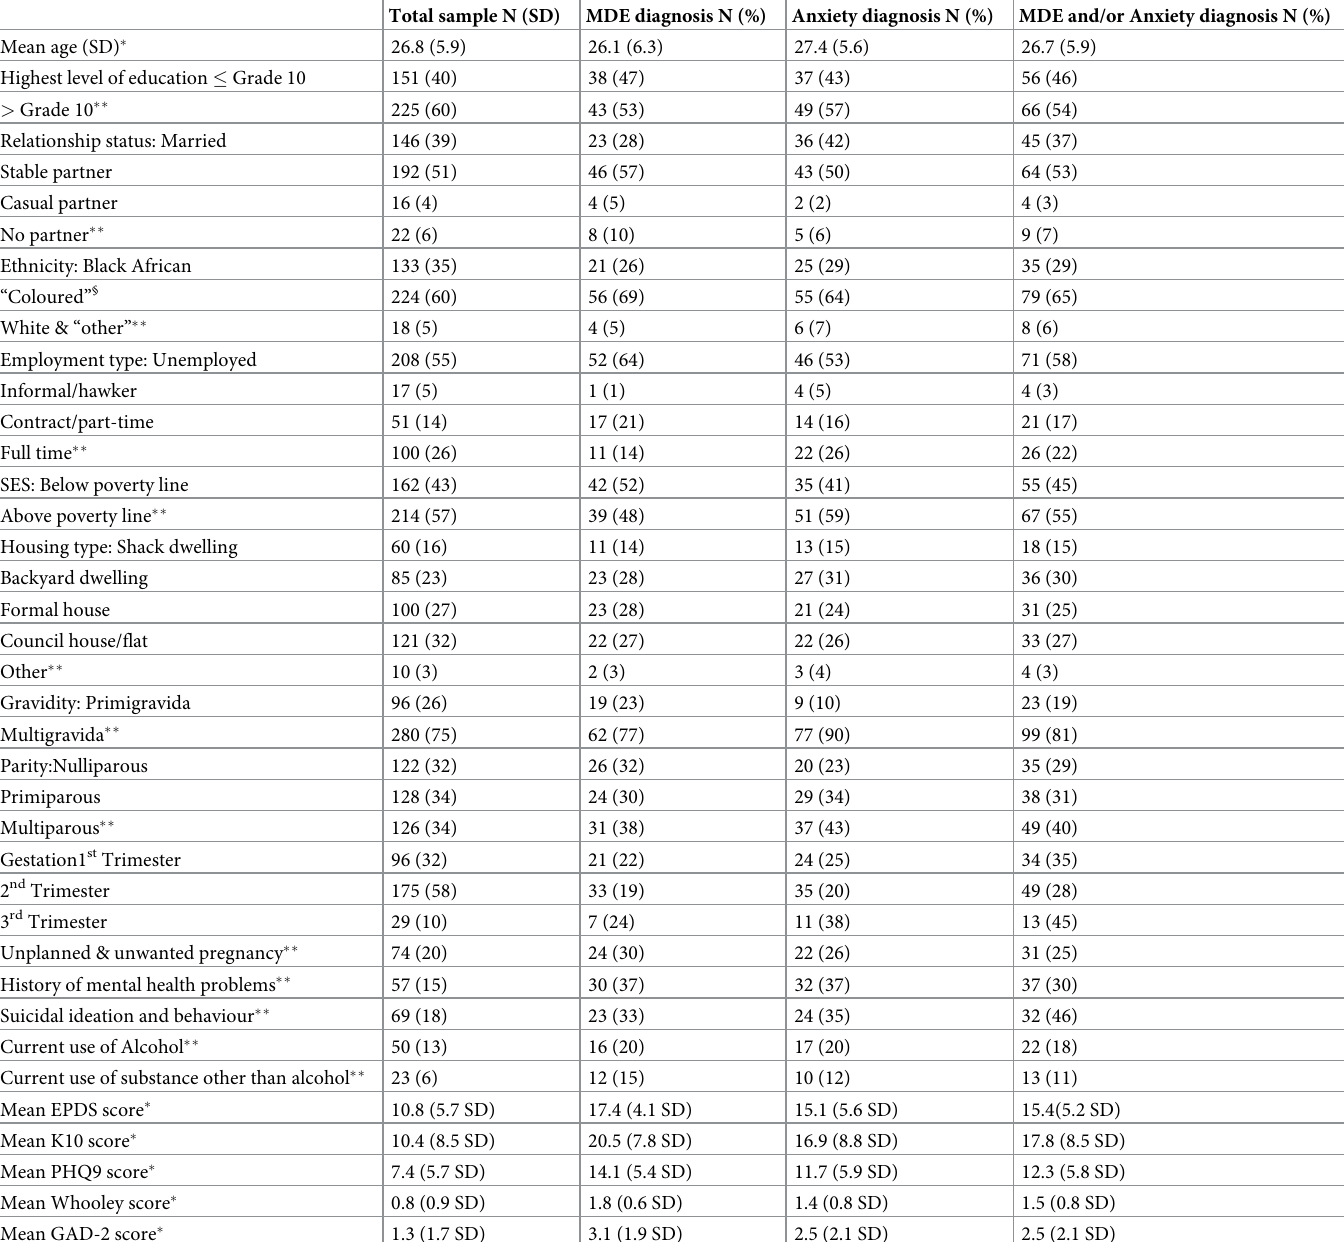
Table 2. Description of the